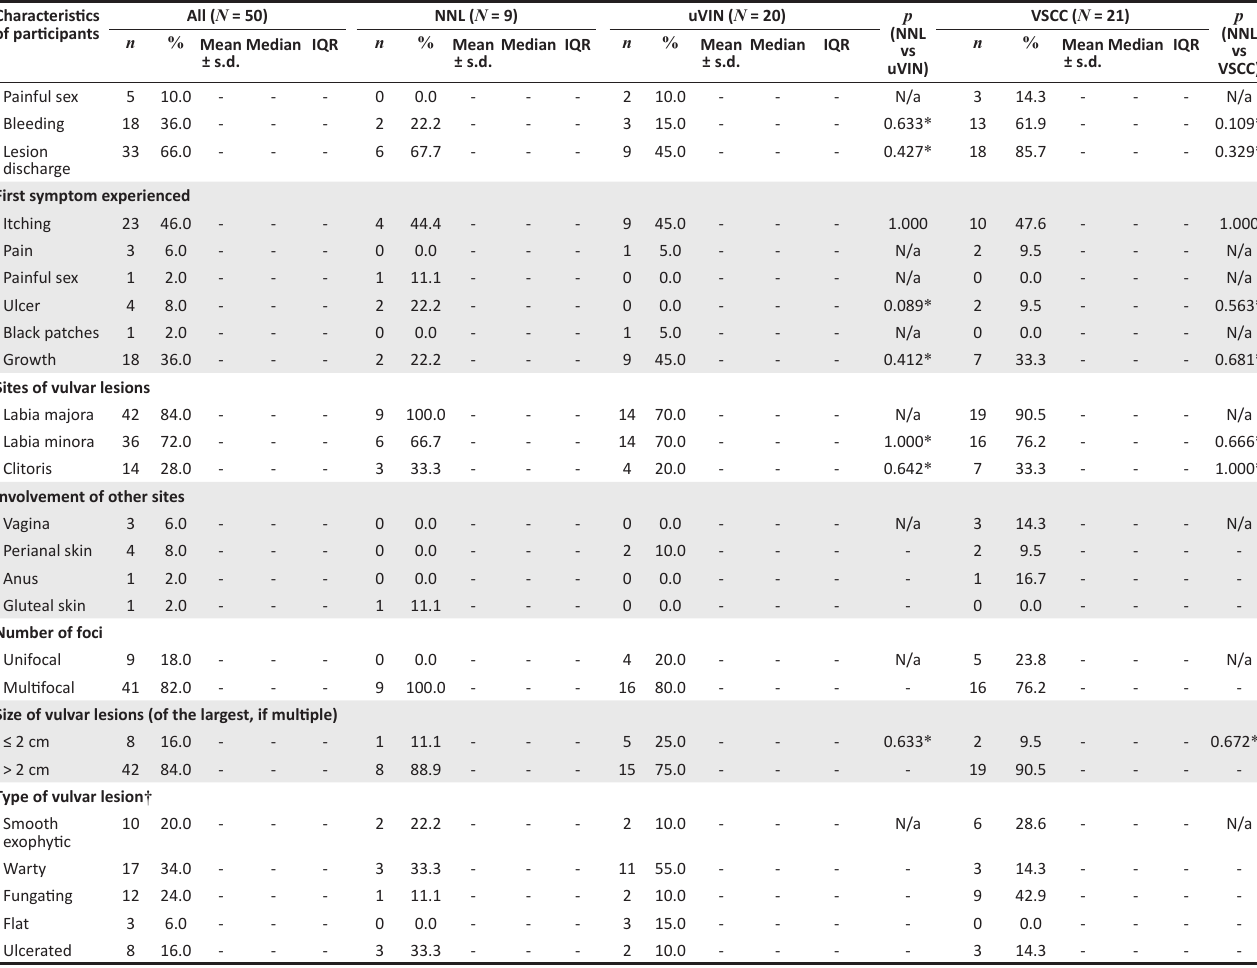
TABLE 1 (Continues...): Characteristics of participants diagnosed with usual uVIN, VSCC and NNL at the University Teaching Hospital’s gynaecologic clinic, Zambia, 2018. Characteristics of